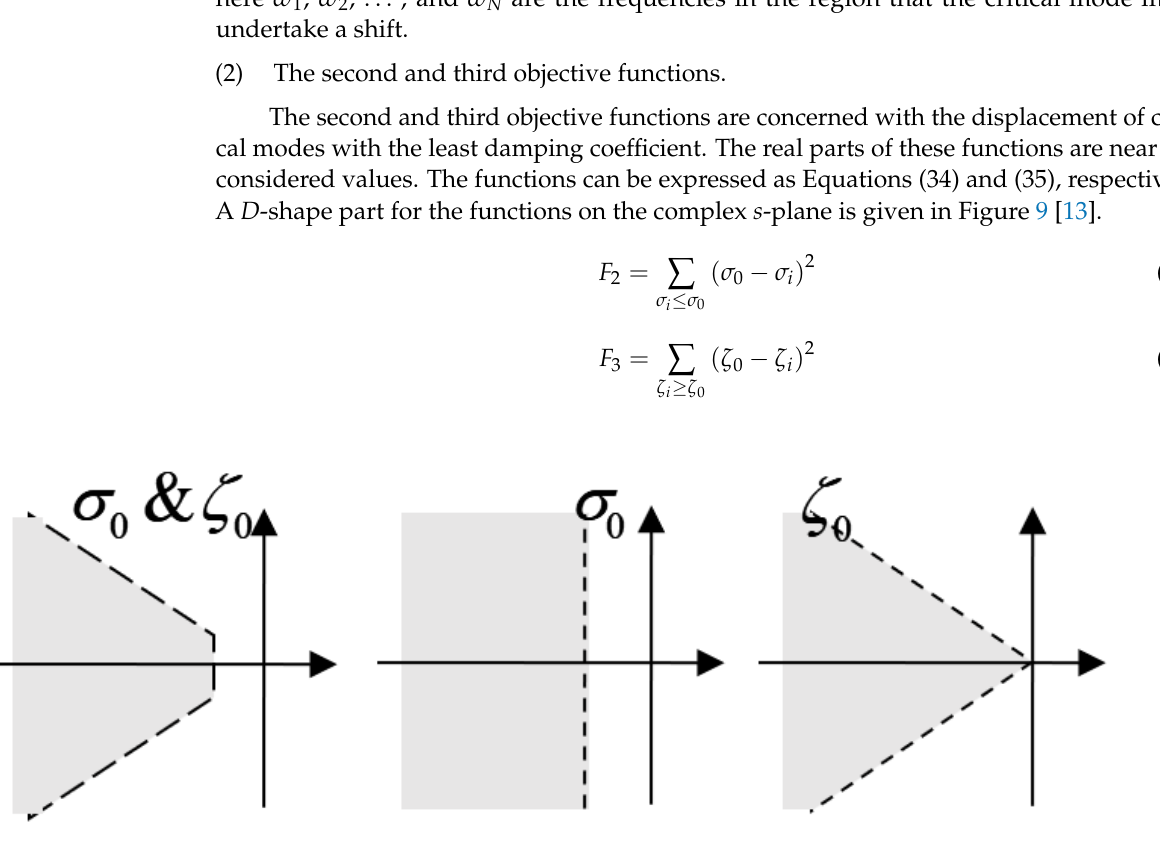
Figure 9. Range of displacement of the eigenvalues.